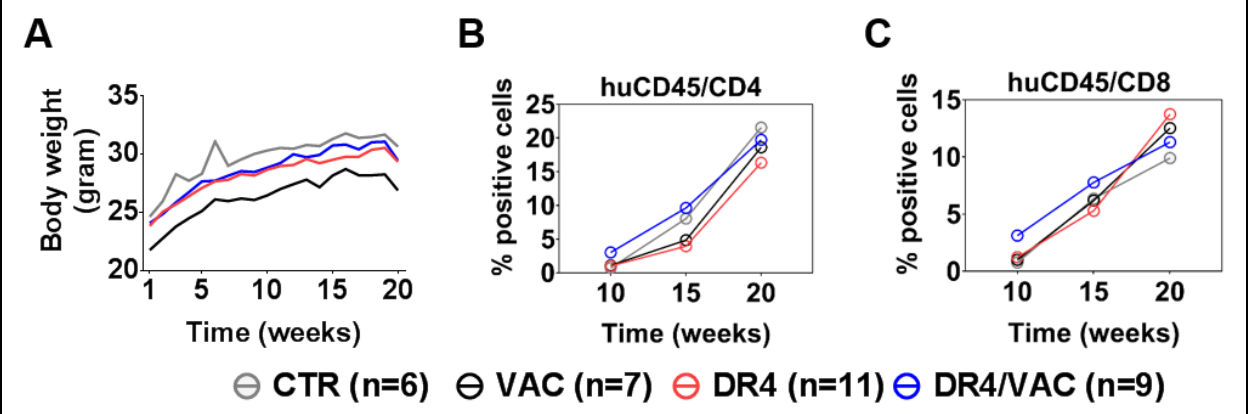
Figure 8. Administration of LV-DR4/fLuc vector in combination with VAC into huNRG is safe and promotes CD4 + and CD8 + T cell development and maturation. ( A ) Weight monitoring of huNRG mice for each cohort after HCT; ( B , C ) longitudinal analyses of CD4 + and CD8 + T cells frequency in peripheral blood by FACS. Data pooled from four independent experiments.